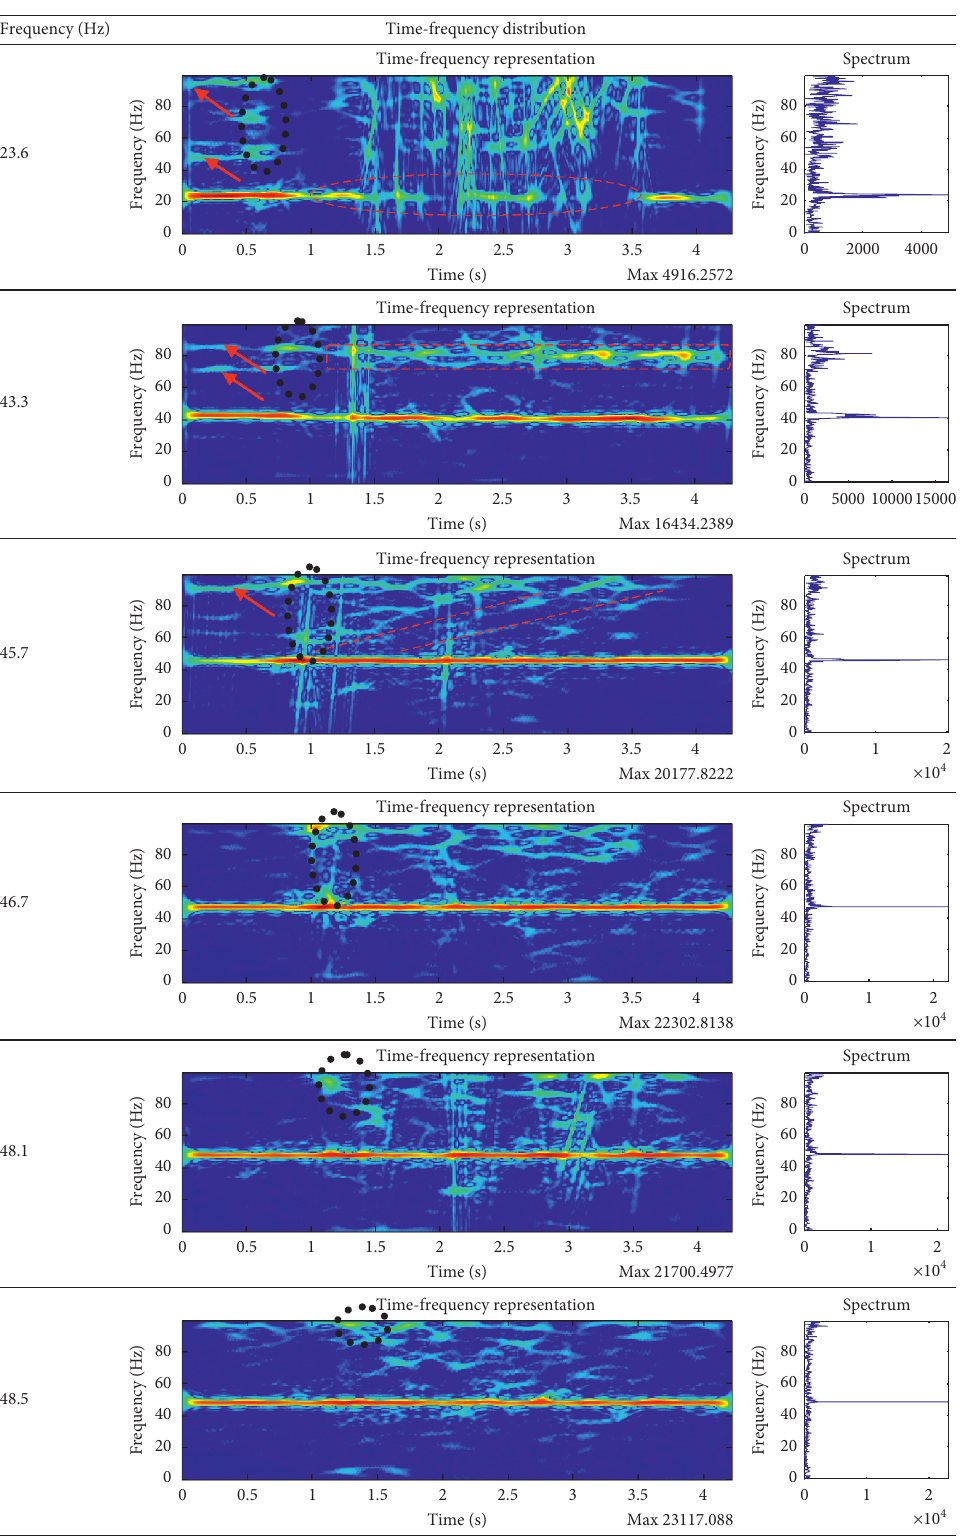
Figure 13: Time-frequency distribution of the transverse rope vibration under different excitation